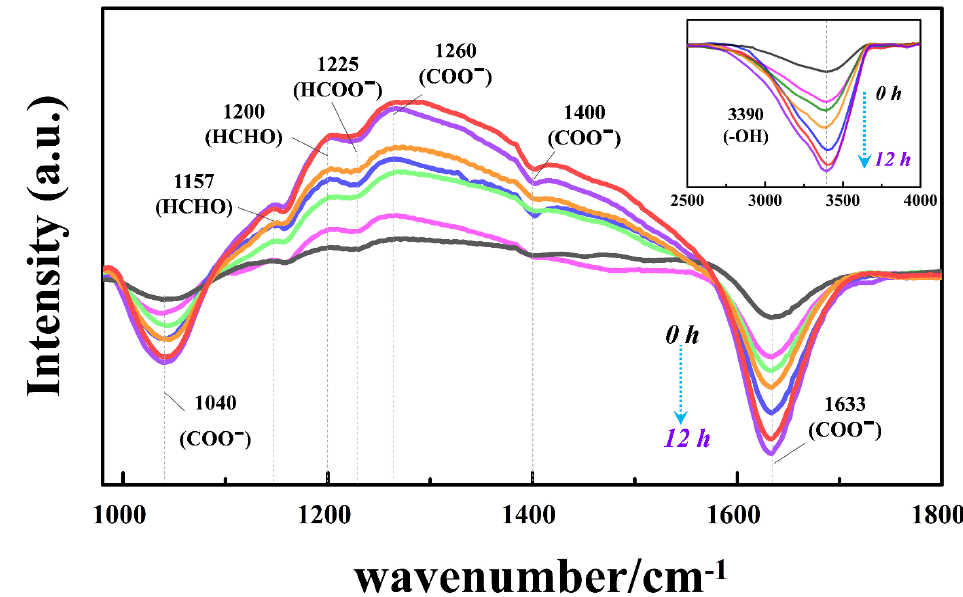
Figure 10. In-situ DRIFTS of AT-420 during the visible-light photodegradation of HCHO.